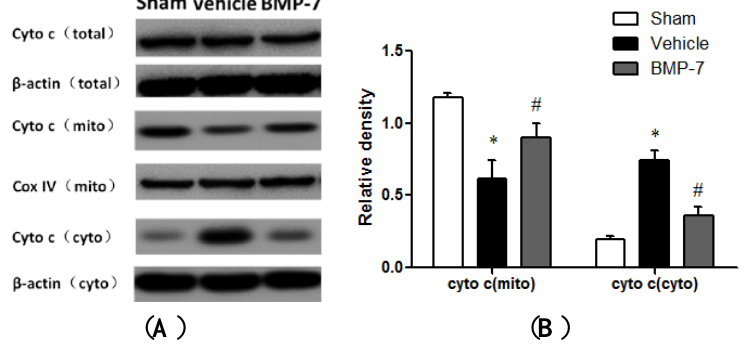
Figure 7. Protein expression of cleaved caspase-3, cleaved caspase-9 and cleaved caspase-8